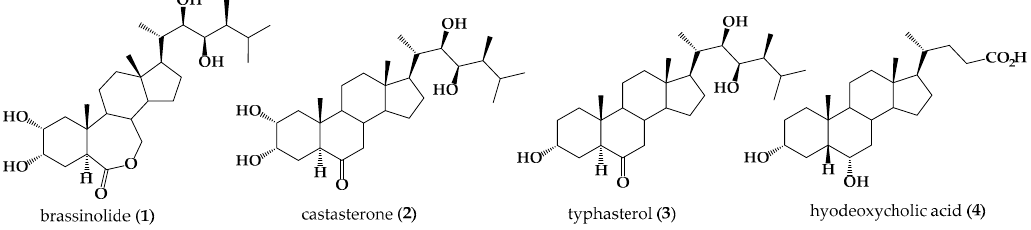
Figure 1. Brassinolide ( 1 ), castasterone ( 2 ), typhasterol ( 3 ) and hyodeoxycholic acid ( 4 ).